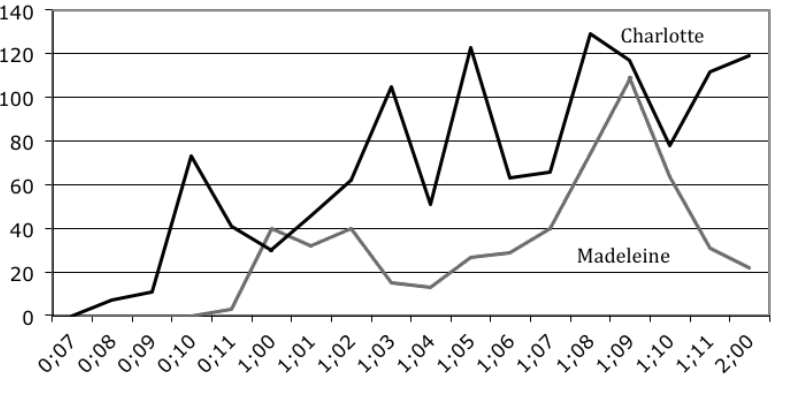
Figure 2. Number of pointing gestures produced in an hour for the two children according to age Morgenstern (2014) has shown that the ratio of Madeleine’s points over the total number of her vocal utterances decreases from 90% of her utterances at 1;0 (which means that almost all her vocal utterances were either accompanied, preceded or followed by a point), to 5 - 10% between 2;0 and 3;0. We cannot conduct the same complete measures on Charlotte for lack of full transcriptions, but if we take into account the measures shown in table 1, at 1;07, Charlotte produces 66 points for 134 turns which is a ratio of almost 50%, whereas Madeleine produces 40 points for 285 turns, which is a ratio of 14%. At 2;0, Charlotte’s proportion of pointing has drastically increased since it is 119 pointing for 152 turns (78%), whereas Madeleine has decreased to 22 for 395 turns (5%). Pointing is thus a predominant feature of Charlotte’s communicative system, whereas it has become much less important in Madeleine’s productions after